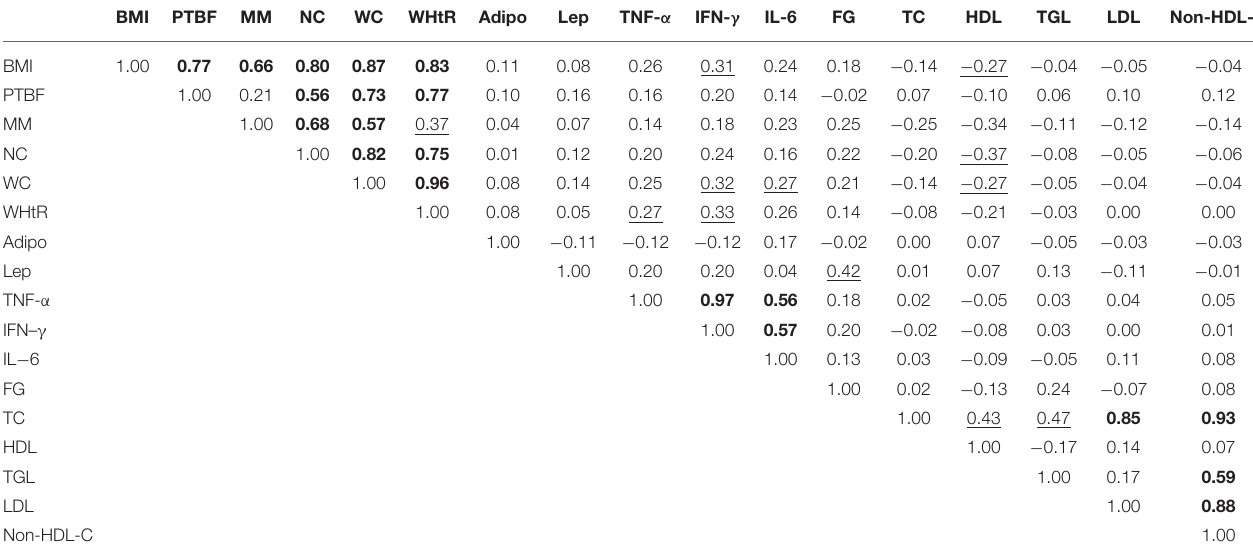
TABLE 10 | Simple Pearson’s correlation coefficients (r) among women for anthropometric parameters, body composition, adipocytokines, and cytokines.